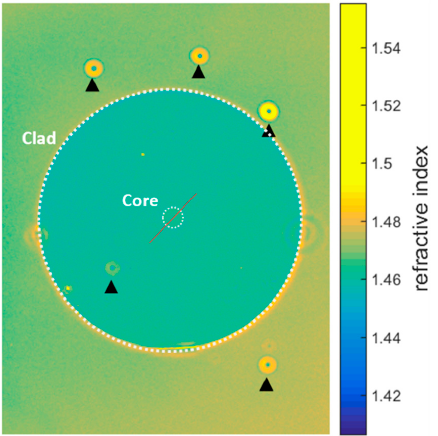
Figure 6. Two dimensional refractive index profile of A1550 fiber obtained from the 2-D refractive index profiling setup. The core and cladding region are circled in white for clarity. The black triangles represent dust particles.